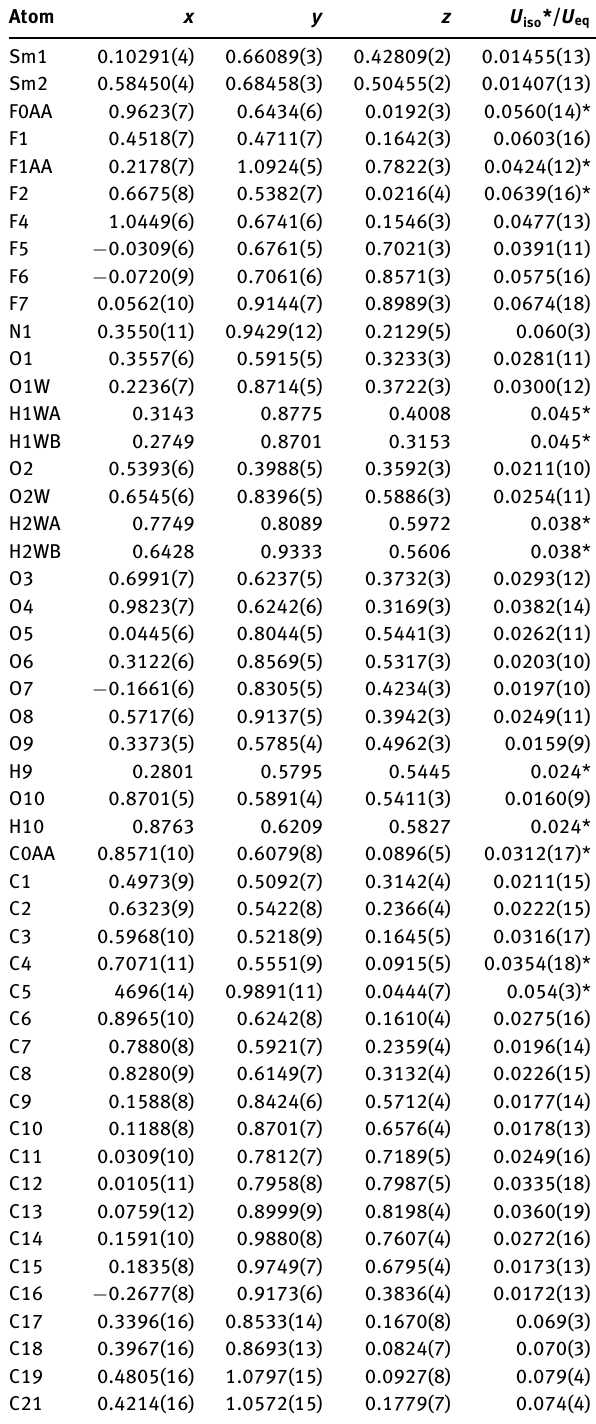
Table 2: Fractional atomic coordinates and isotropic or equivalent isotropic displacement parameters (Å 2